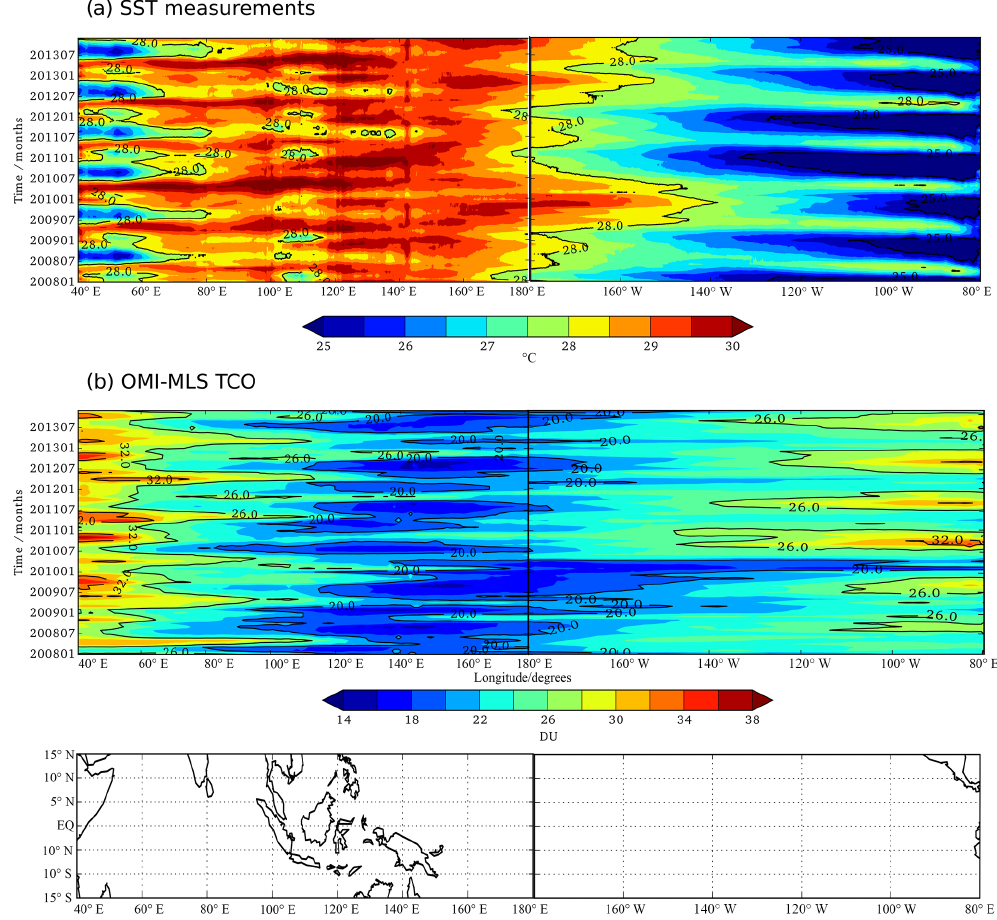
Figure 5. (a) Time versus longitude Hovmöller diagram of the SST (in ◦ C). (b) Same diagram from the OMI-MLS data. The data are monthly means from January 2008 to December 2013 and area-averaged between latitudes 15 ◦ S and 15 ◦ N. Also included on the bottom are the corresponding maps of the Hovmöller